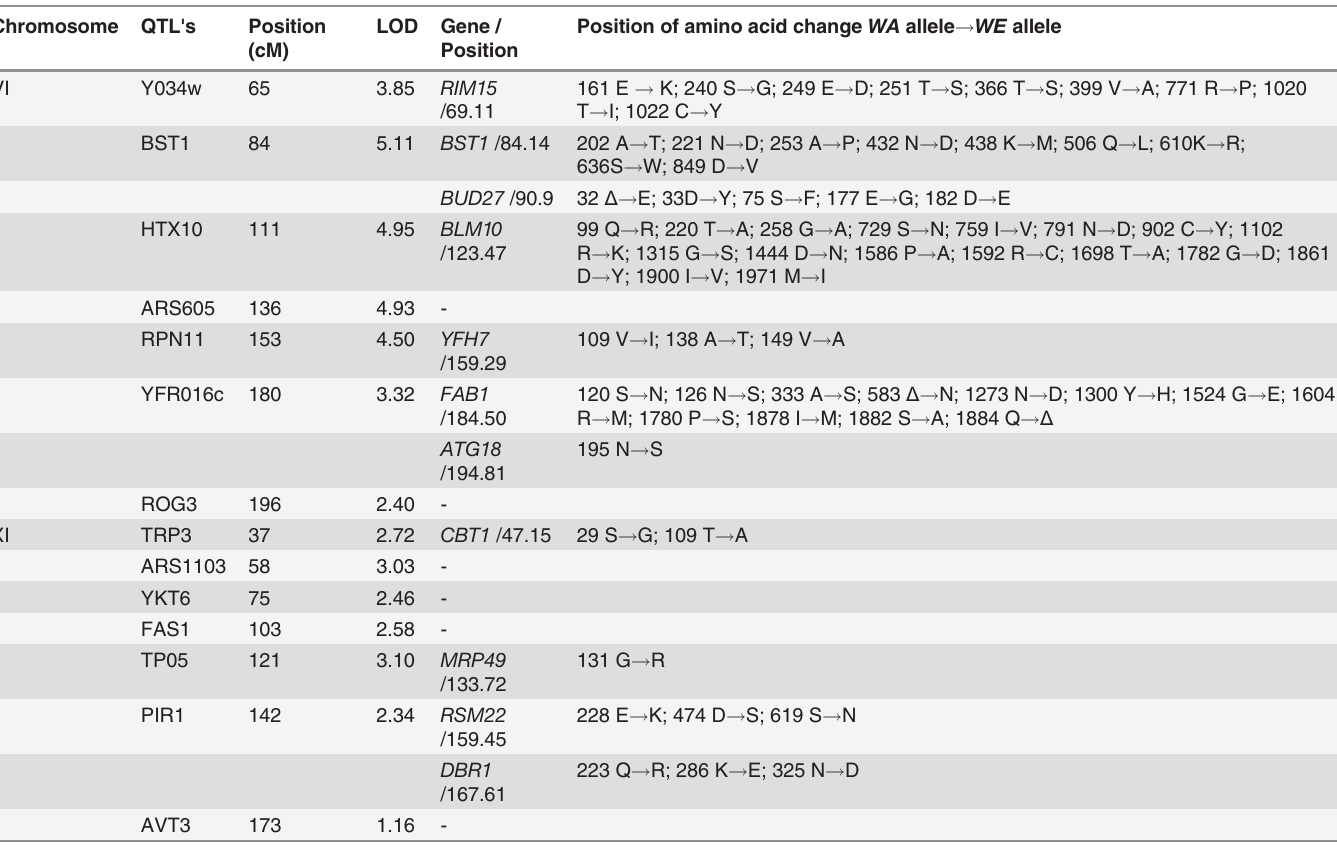
Table 2. The position in the genome, significance value, genes in the respective regions and the differences in the amino acid sequence for each gene in WE strain versus WA are described. Chromosome QTL's Position LOD Gene / Position of amino acid change WA allele ! WE (cM) Position